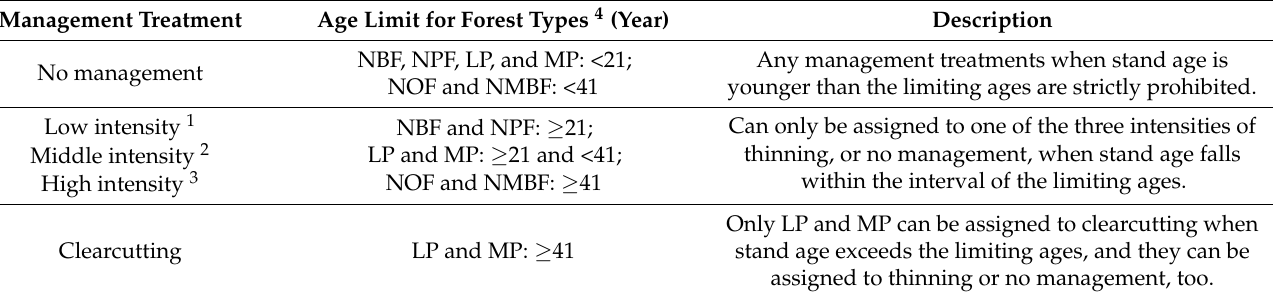
Table 1. Overview of the management treatments for the planning